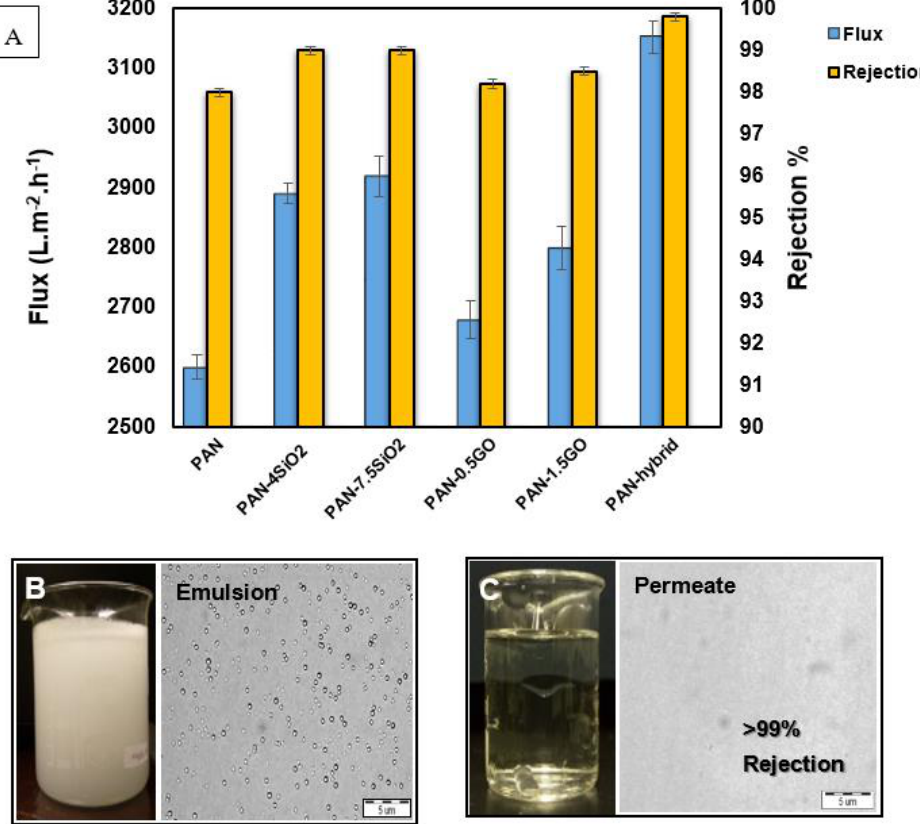
Figure 6. ( A ) Flux of permeate and rejection% of oil for the developed membranes with different nanofillers; ( B ) optical image of milky white emulsion with oil droplets; ( C ) optical image of permeate from hybrid membrane showing no oil droplets.